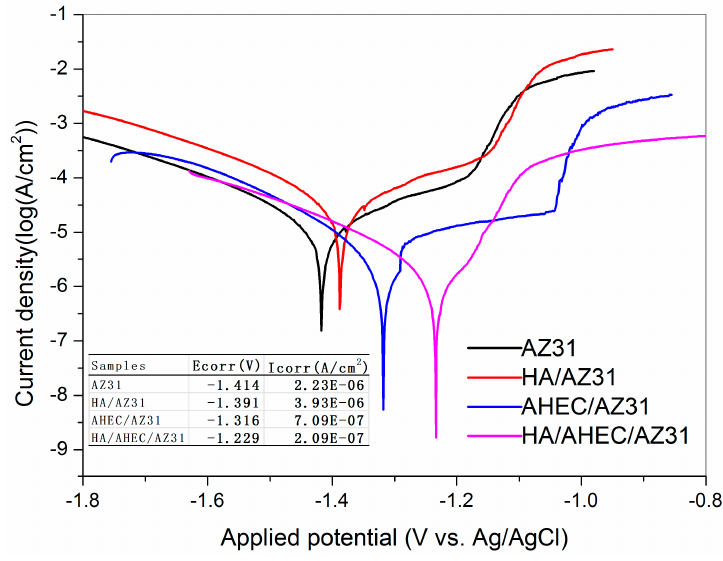
Figure 4. The potentiodynamic polarization curves for AZ31, HA/AZ31, AHEC/AZ31, and HA/AHEC/AZ31 in SBF at room temperature; the relative electrochemical parameters are listed in the inset.